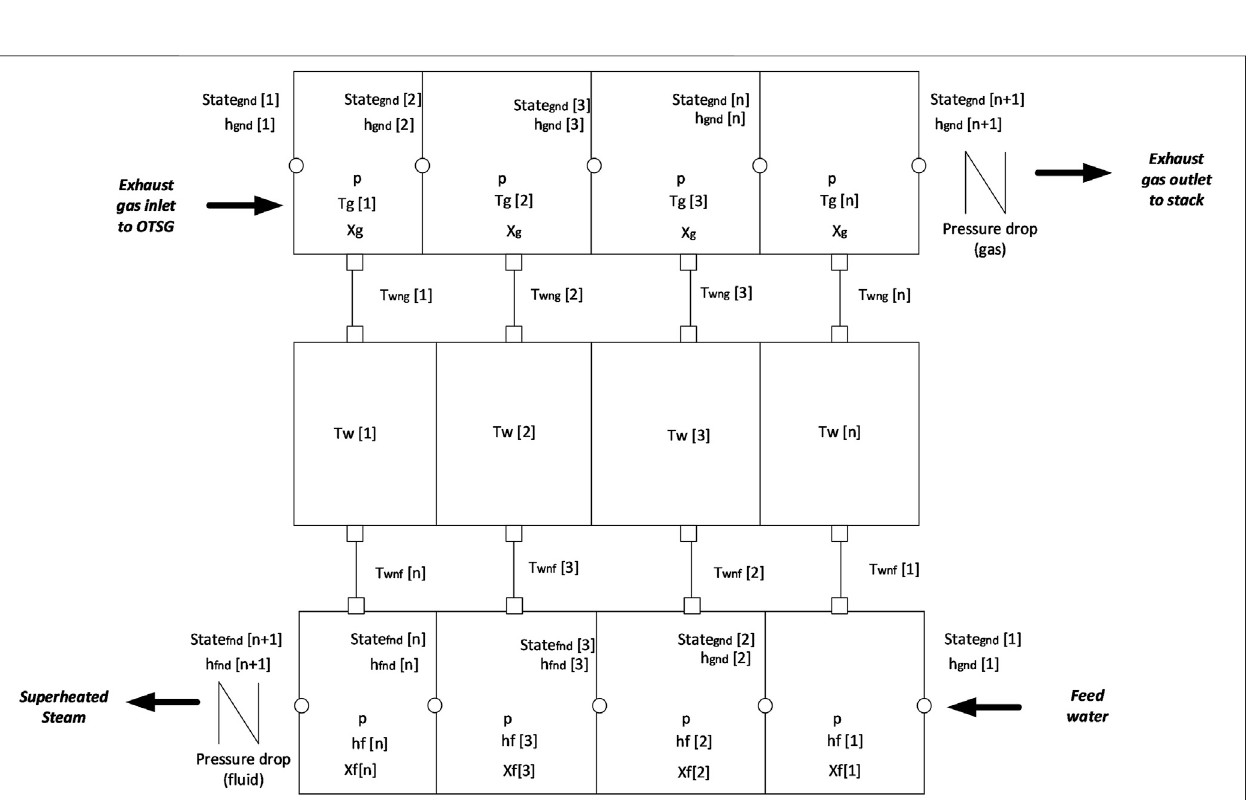
FIGURE 4 | Discretized dynamic OTSG model with lumped pressure in fl uids and pressure drop at the outlet. Gas pipe: Mass-fraction, and energy balance equations are discretized with the fi nite volume method. State variables are one lumped pressure p, n temperatures Tg, mass fractions and trace concentrations in fl ue gas(Xg).Waterpipe:Mass-fraction,andenergybalanceequationsarediscretizedwiththe fi nitevolumemethod.Statevariablesareonelumpedpressurep,nenthalpies hfn, mass fractions and trace concentrations in fl ue gas (Xf,j). Wall model: 1-dimension model of a metal wall where the heat capacity is lumped at the center of the wall. The fi gure here is an example with n (cid:1)